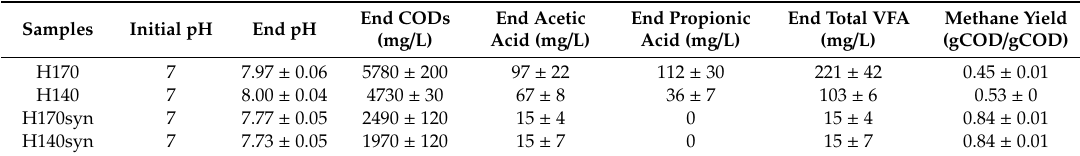
Table 7. Initial pH values and e ffl uent characteristics at the end of AMPTS II experiments.